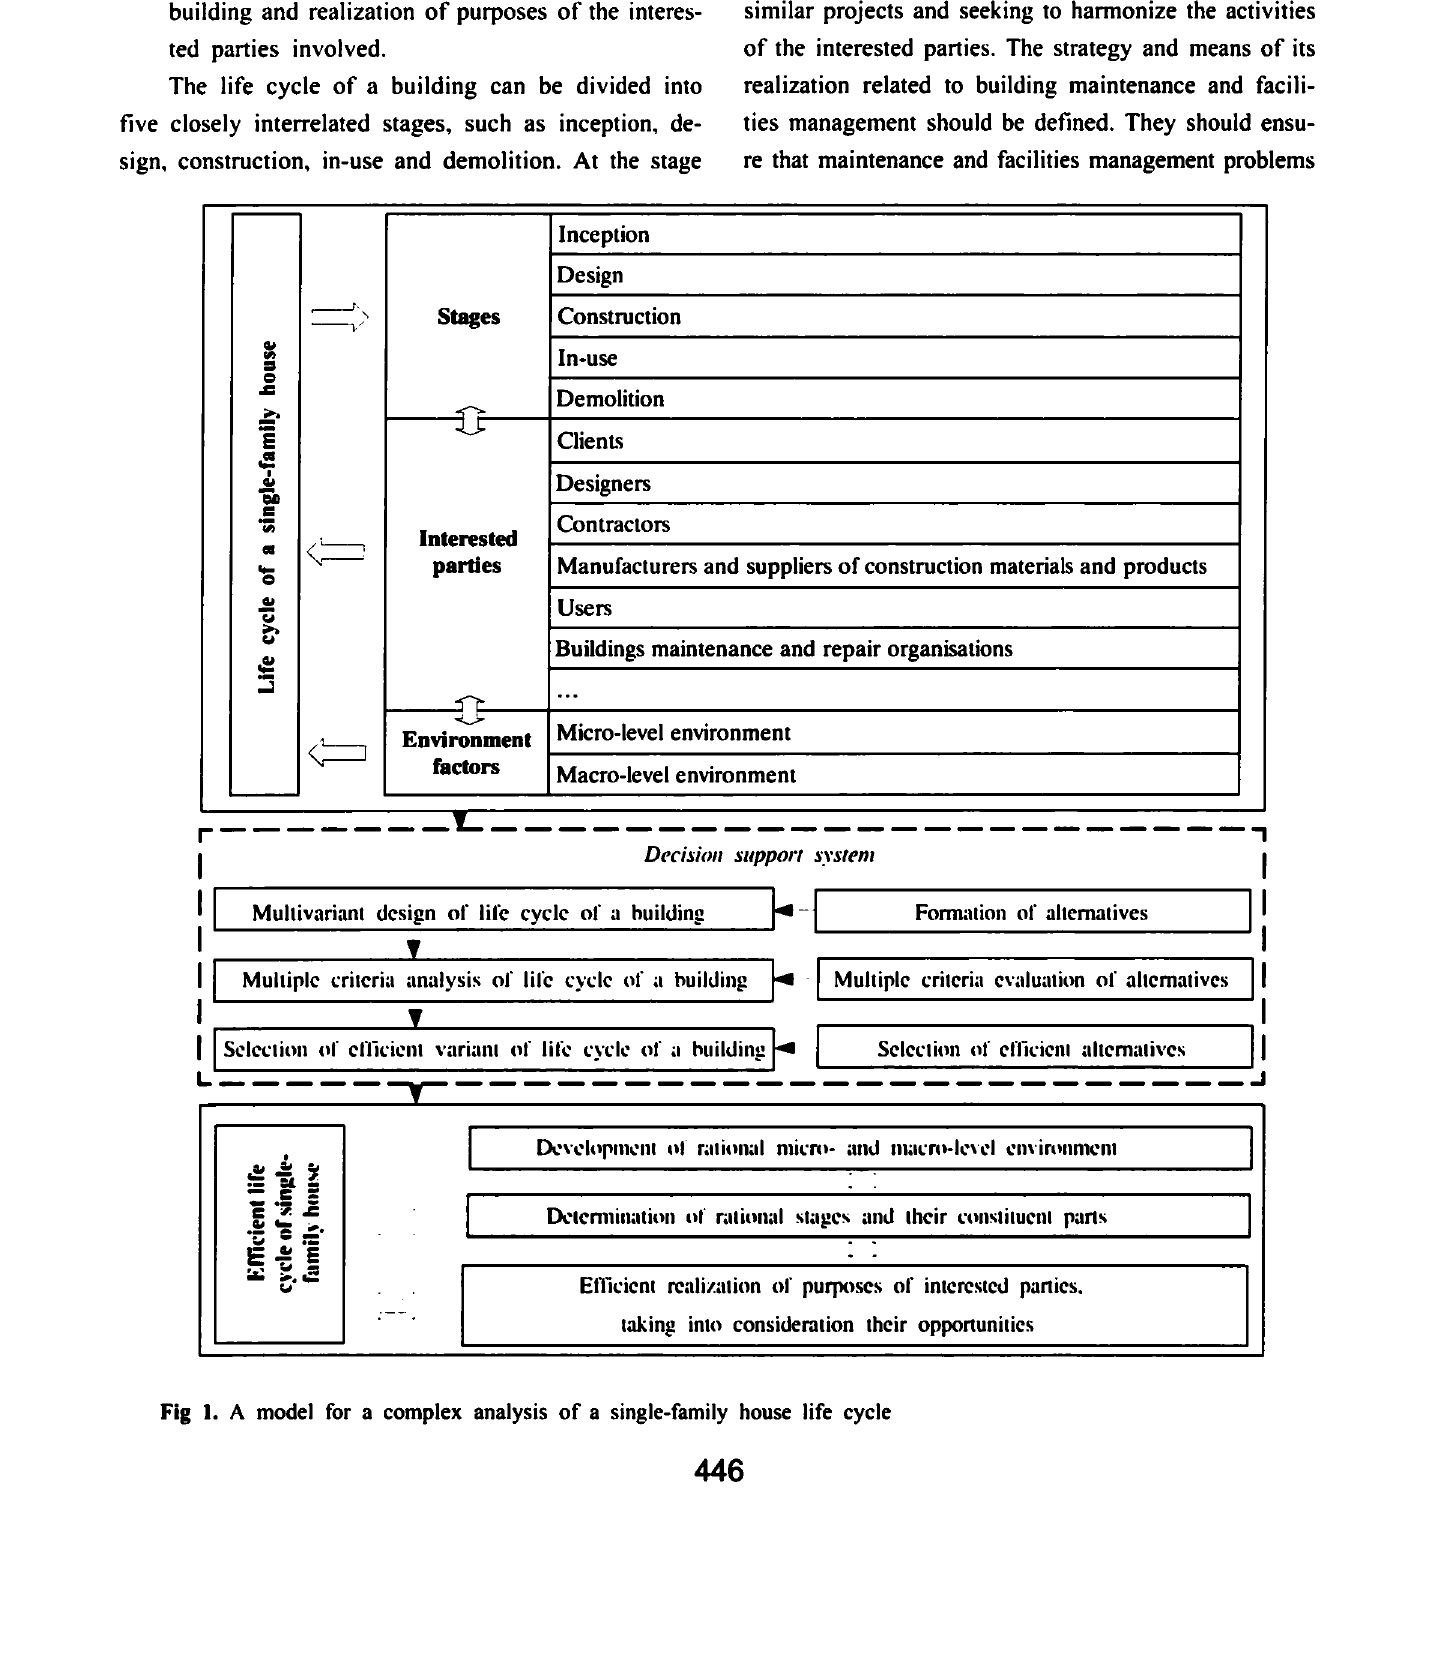
Fig 1. A model for a complex analysis of a single-family house life